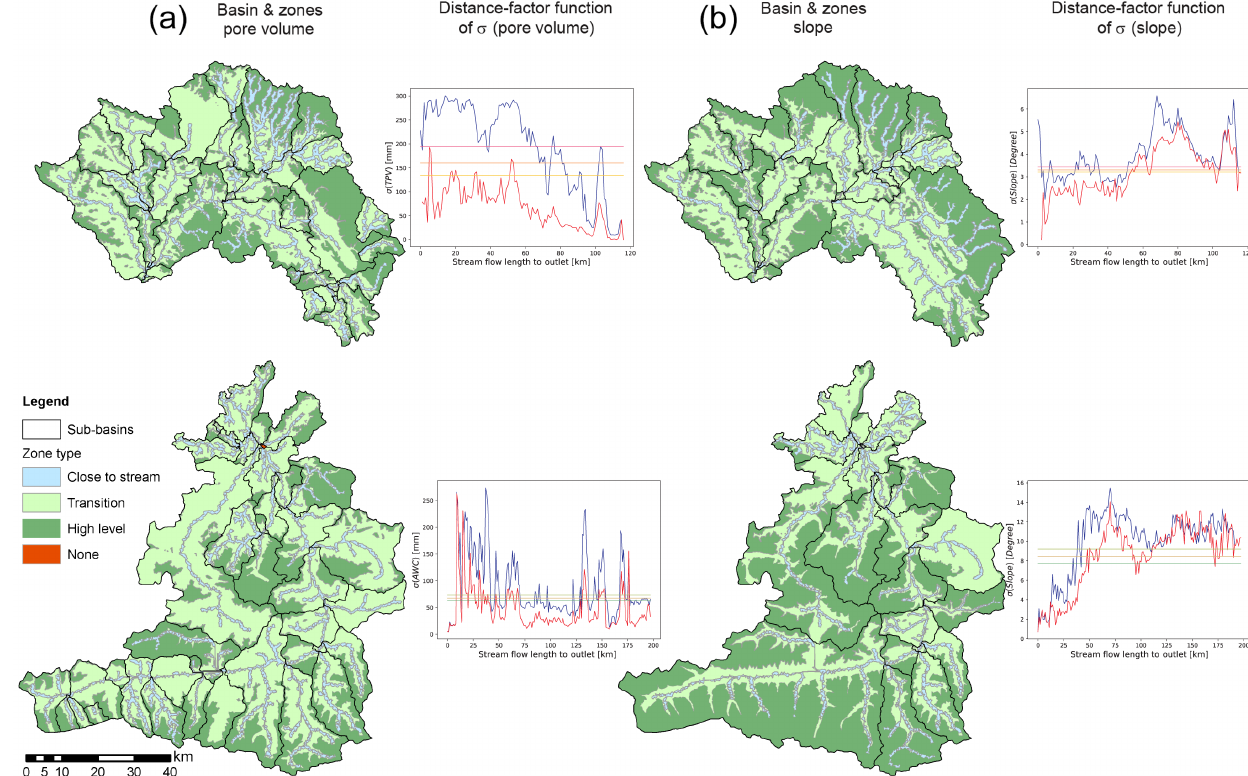
Figure 10. Results of ACS application for catchments of the Main and Salzach (from top to bottom), sub-basins based on pore volume (a) and slope (b) . Comparison of σ U (C) and σ S (C) for each application (red and blue lines). Table 1. Results of applications of ACS. Number of ascertained sub-basins and normalized reduction of standard deviation. Catchment Pore volume Slope No. of α 1 α 2 No. of α